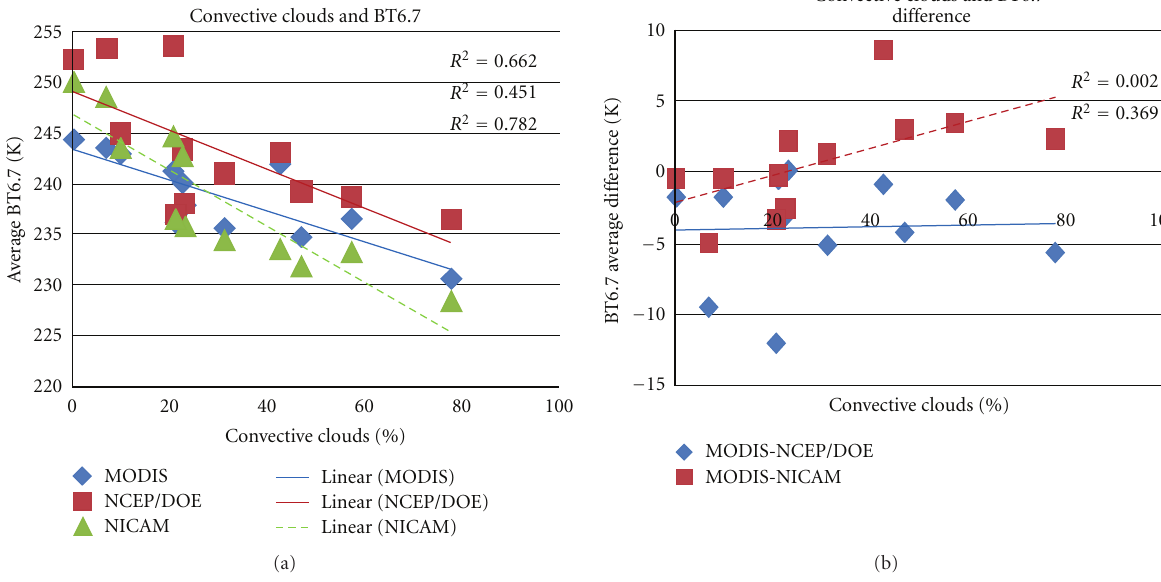
Figure 7: Variation of the convective cloud cover (%) for each MODIS scene with the average observed brightness temperature at 6.7 μ m wavelength (BT6.7) (a), then the BT6.7 di ff erence (MODIS-NCEP/DOE and MODIS-NICAM) (b). The determination coe ffi cients on the right of (a) are, respectively, for MODIS (upper), NCEP/DOE (middle), and NICAM (lower); for (b), they are for MODIS-NCEP/DOE (upper) and MODIS-NICAM (lower).